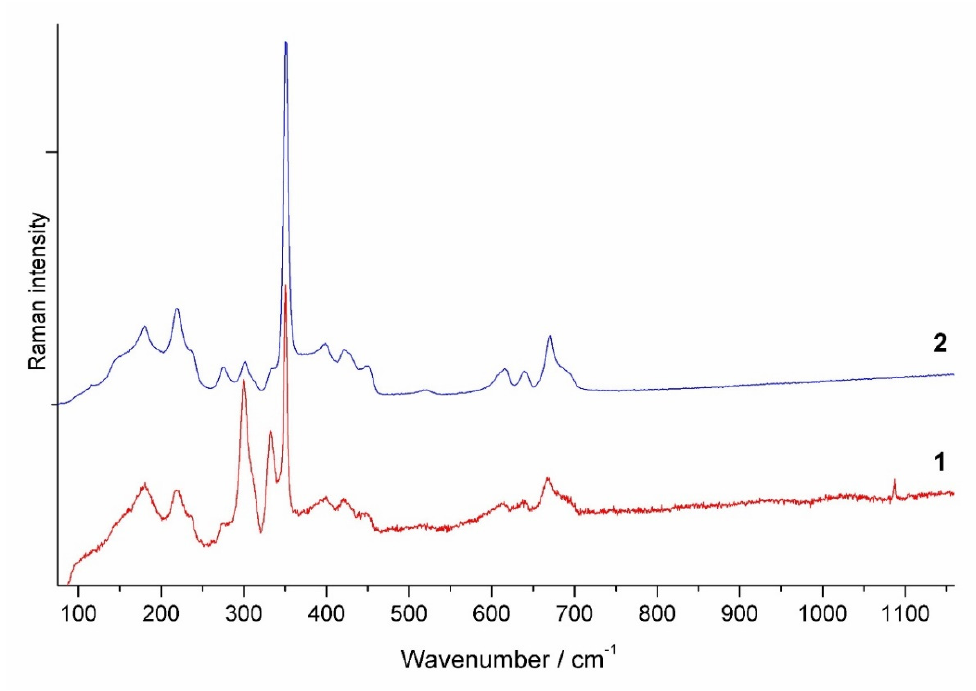
Figure 11. Raman spectra of natural CM sphalerite from sample DT-20 (1) compared with sphalerite from Arizona [RRUFF base] (2).